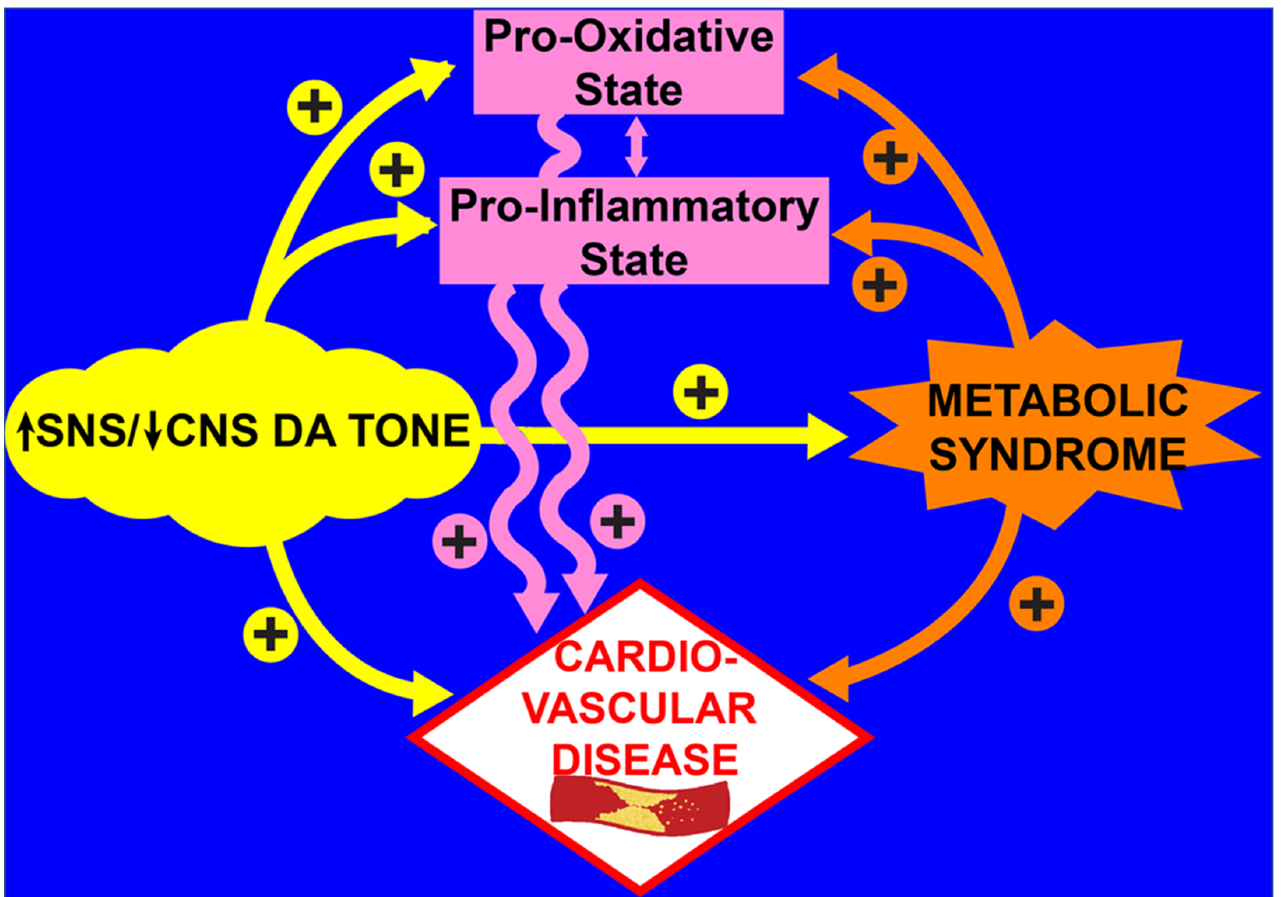
Figure 8. Schematic of interacting, parallel, and reinforcing pathways of increased SNS and decreased CNS dopaminergic tone in the development of cardiovascular disease.